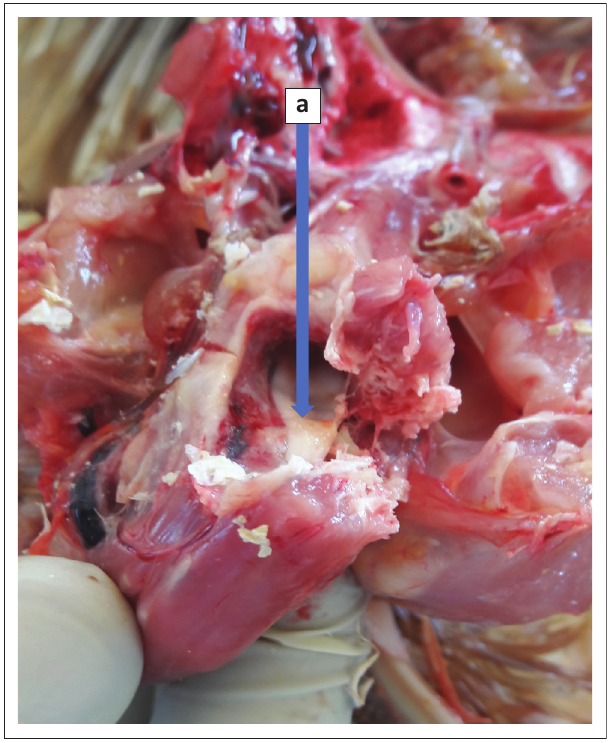
FIGURE 2: Cervical spinal cord compression (a) clearly visible through the cut surface of the cervical